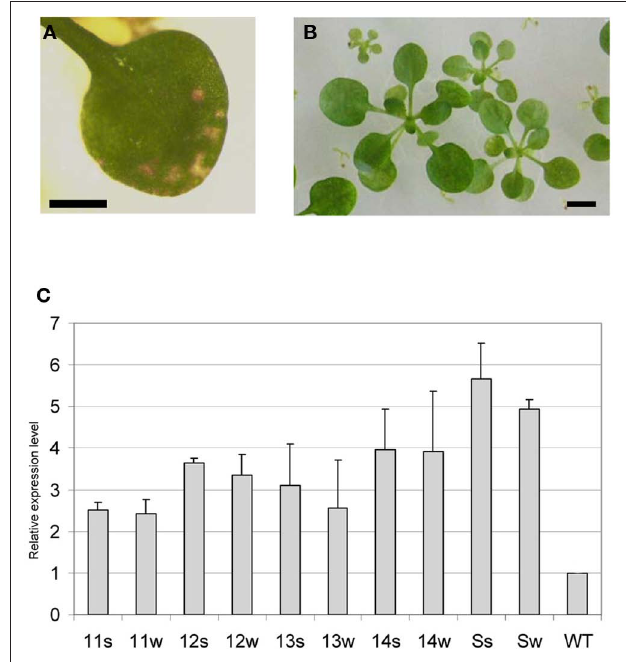
FIgURe 12 | Phenotype and expression level of At1g13020 overexpression lines. (A) Necrotic spots on a leaf of a primary transformant overexpressing At1g13020 cDNA. (B) Sizes of seedlings of an At1g13020 overexpression line. (C) Relative expression level of At1g13020 as determined via Q-RT-PCR in progeny seedlings with a strong phenotype (s) or weak phenotype (w) of four overexpression lines (11, 12, 13, 14) and the sns-D mutant compared to wild-type plants (WT). The expression level in the wild-type was set on 1 and the SD in the mutants was indicated by error bars.